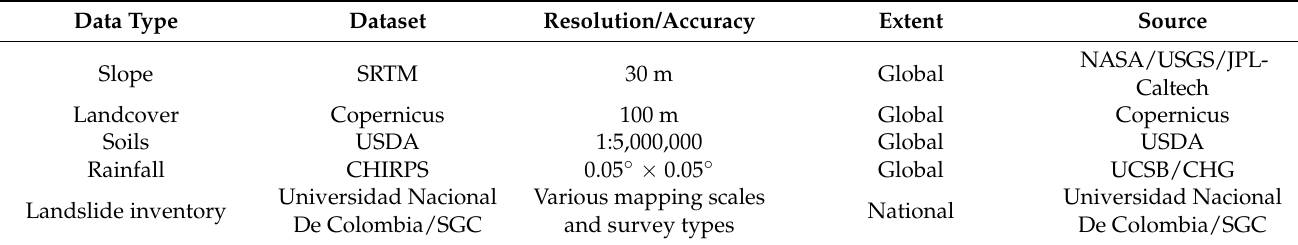
Table 1. Datasets used in this